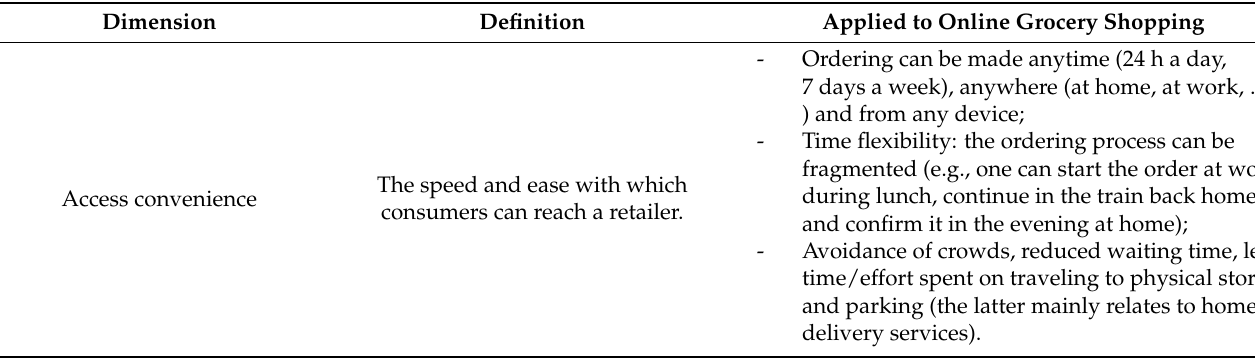
Table 1. Dimensions of convenience applied to e-grocery